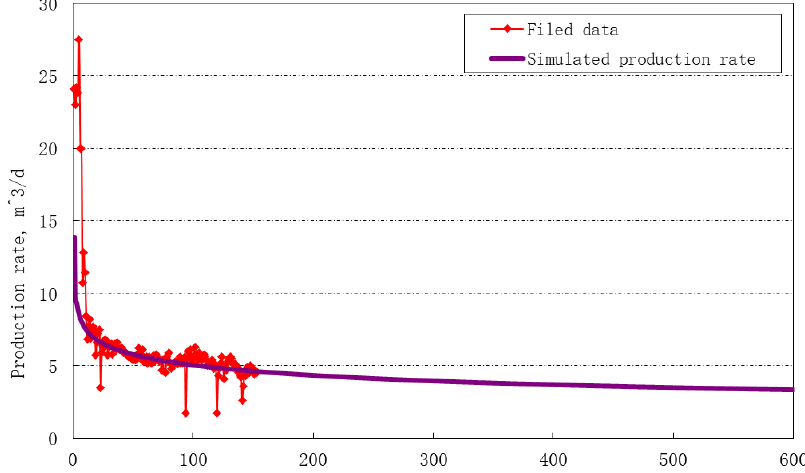
Figure 11. History matching of production rate.